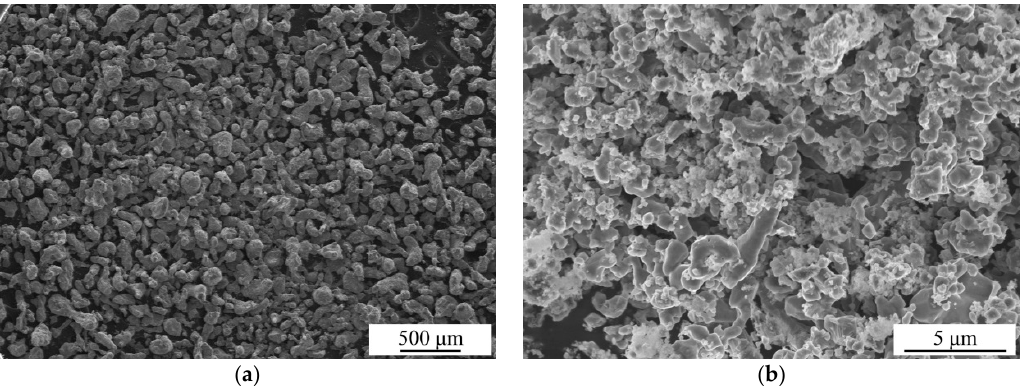
Figure 2. Scanning electronic microscopy (SEM) images of the as-received Al particles ( a ) and as-prepared Al* particles ( b ). as-prepared Al* particles ( b